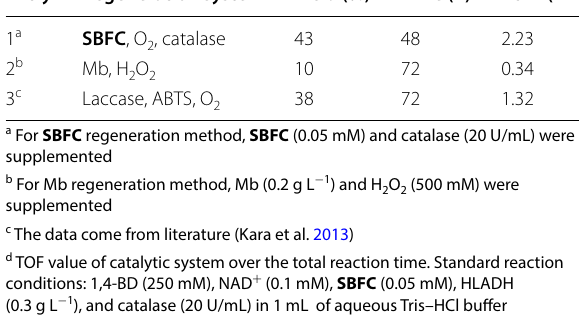
5. = 1. Detection after =